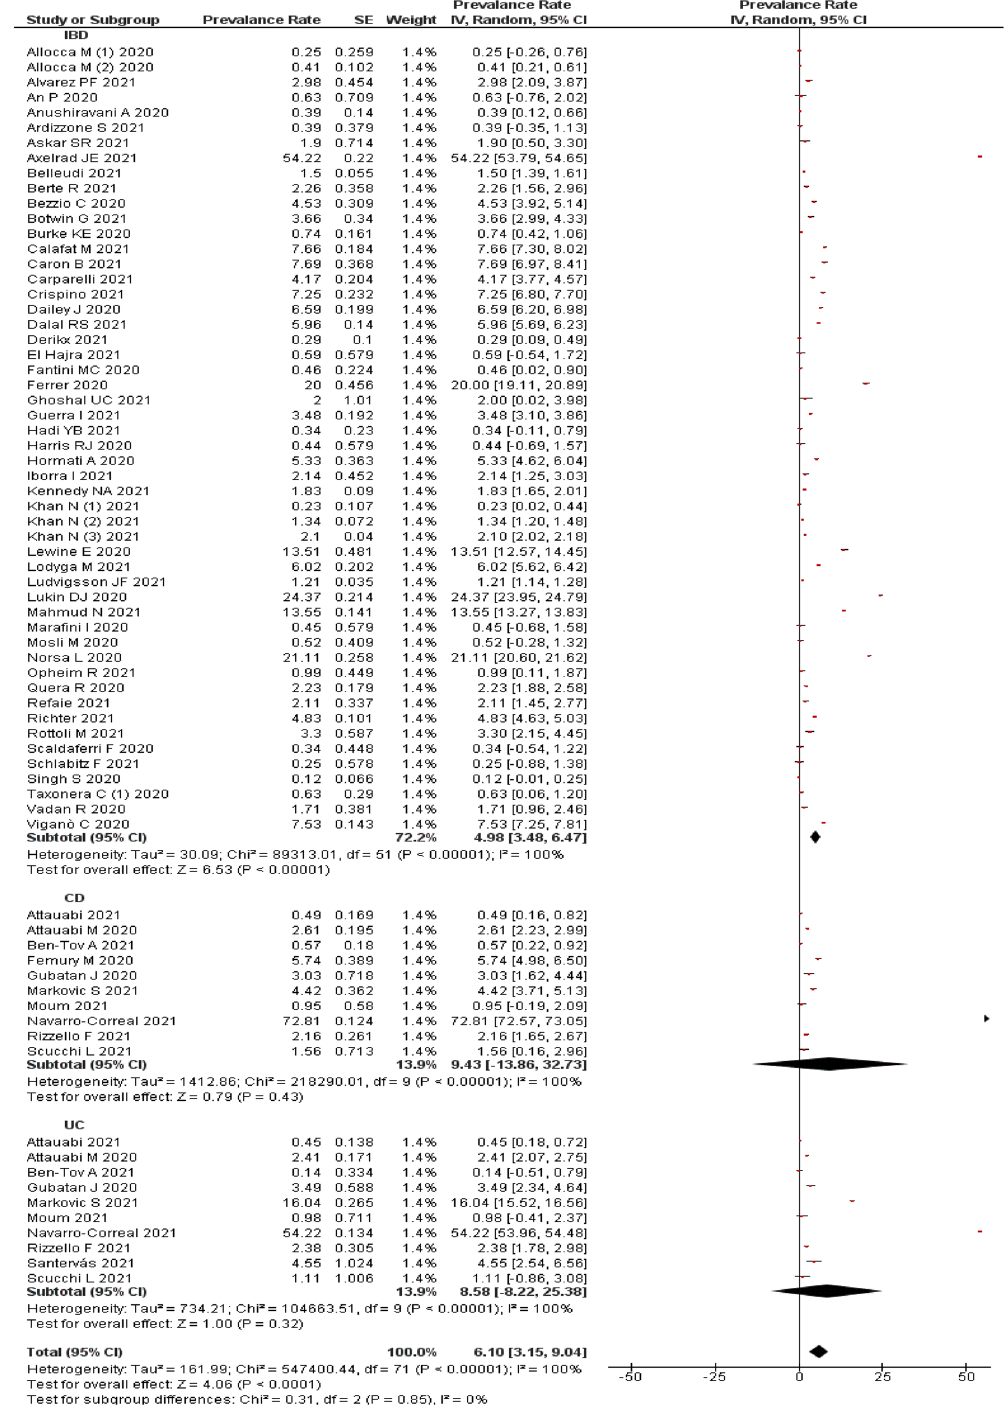
Figure 2. Prevalence of COVID-19 in patients with